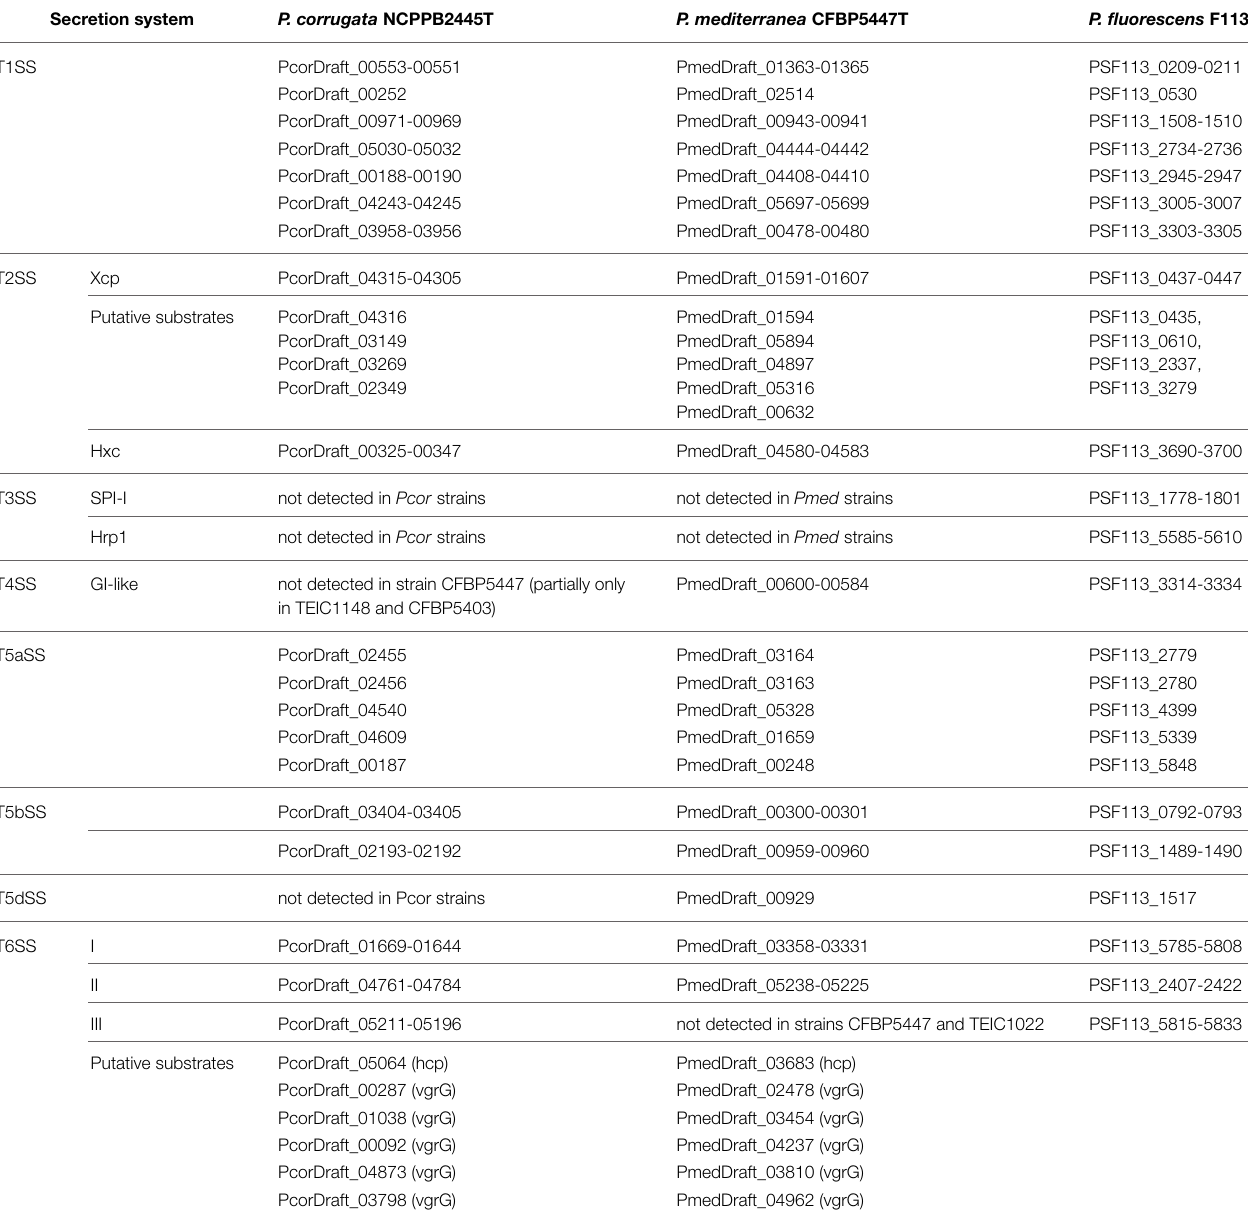
TABLE 5 | The full repertoire of protein secretion/translocation systems of Pseudomonas corrugata ( Pcor ) and P. mediterranea ( Pmed ) type strains. Secretion